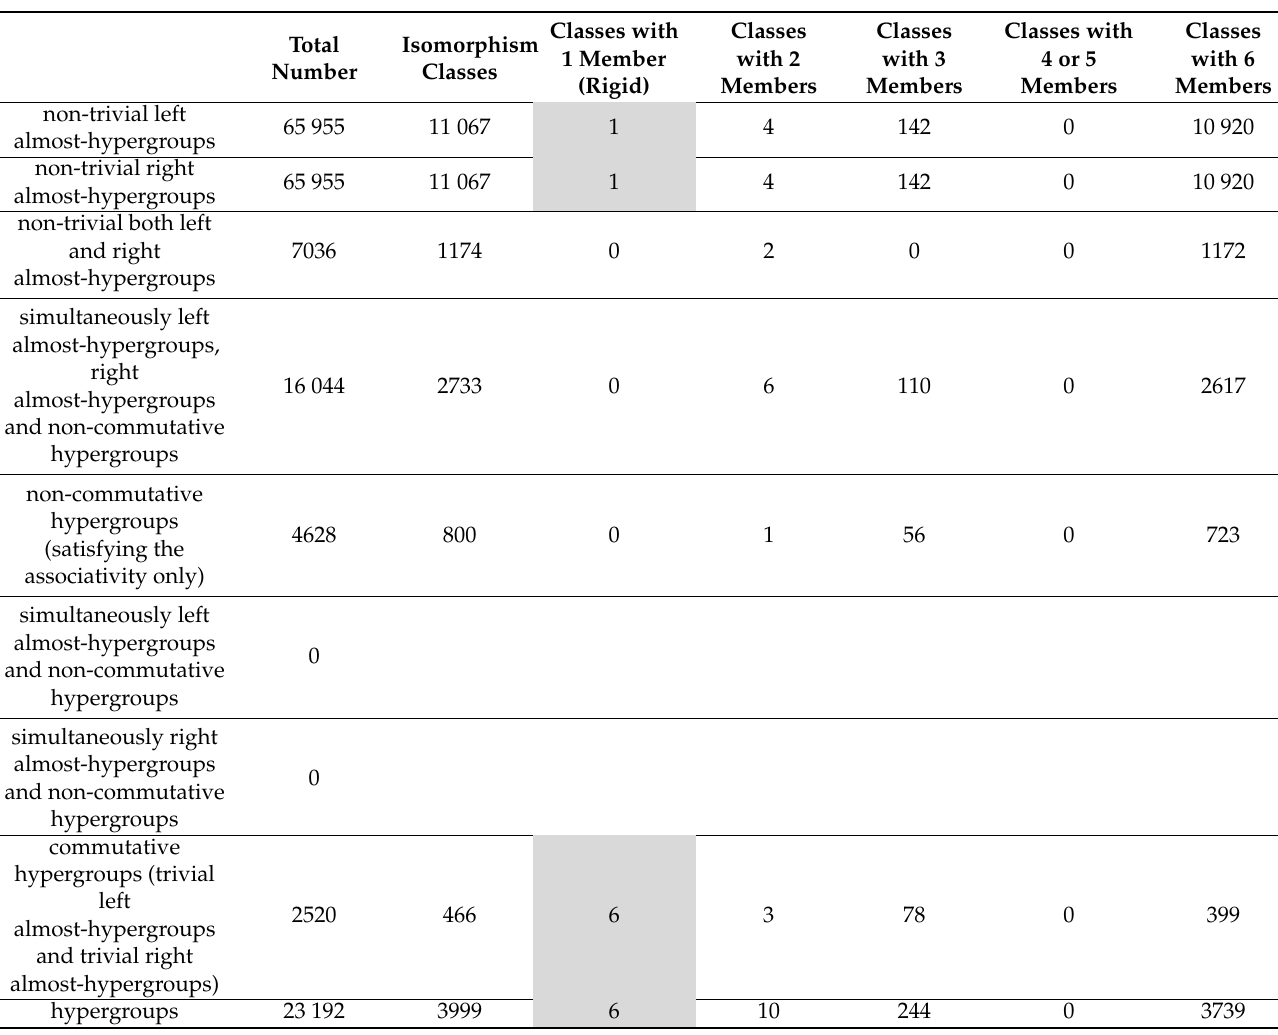
Table 14. Classification of the LA-hypergroups and the RA-hypergroups with three elements.